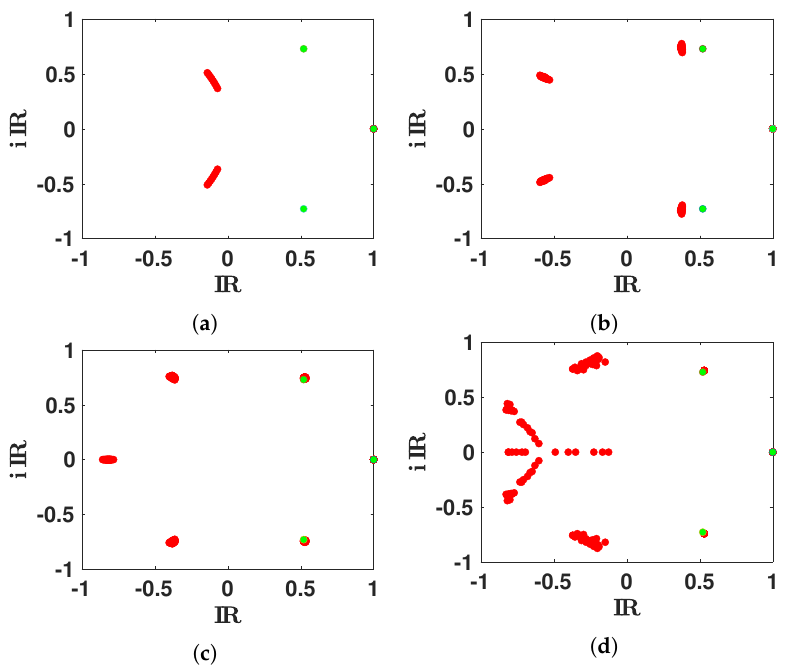
Figure 8. We plot the spectrum of the Leslie matrix L (red dots) when n = 3,5,6,7, (respectively in ( a – d )) giving the best match to the secondary eigenvalues λ (cid:63) correspond to the spectrum of L for all the possible matrices L , having their second pair of eigenvalues close to the minimal distance to λ (cid:63)